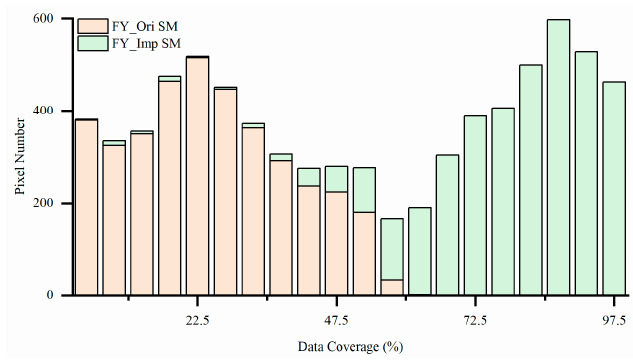
Figure 5. Histograms of data coverage (in %) for FY_Ori SM and FY_Imp SM over the Tibetan Plateau.